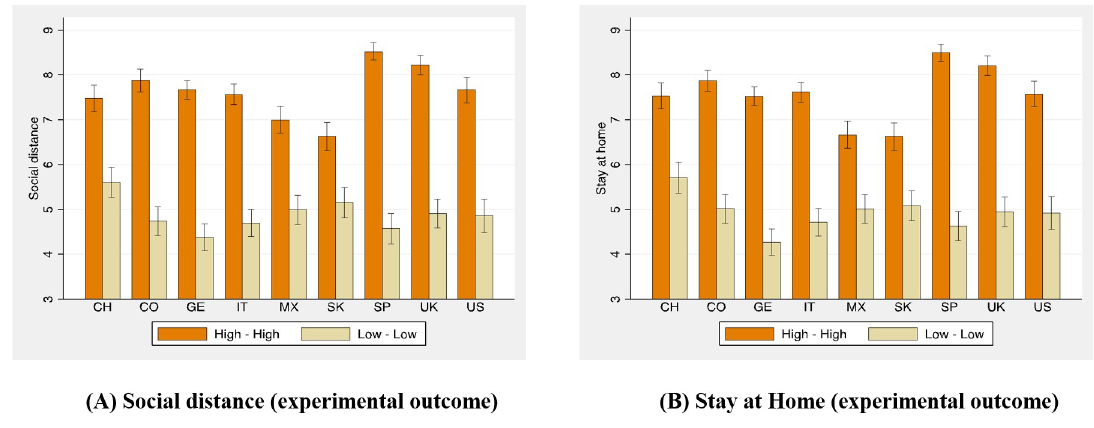
Fig 1. The new social